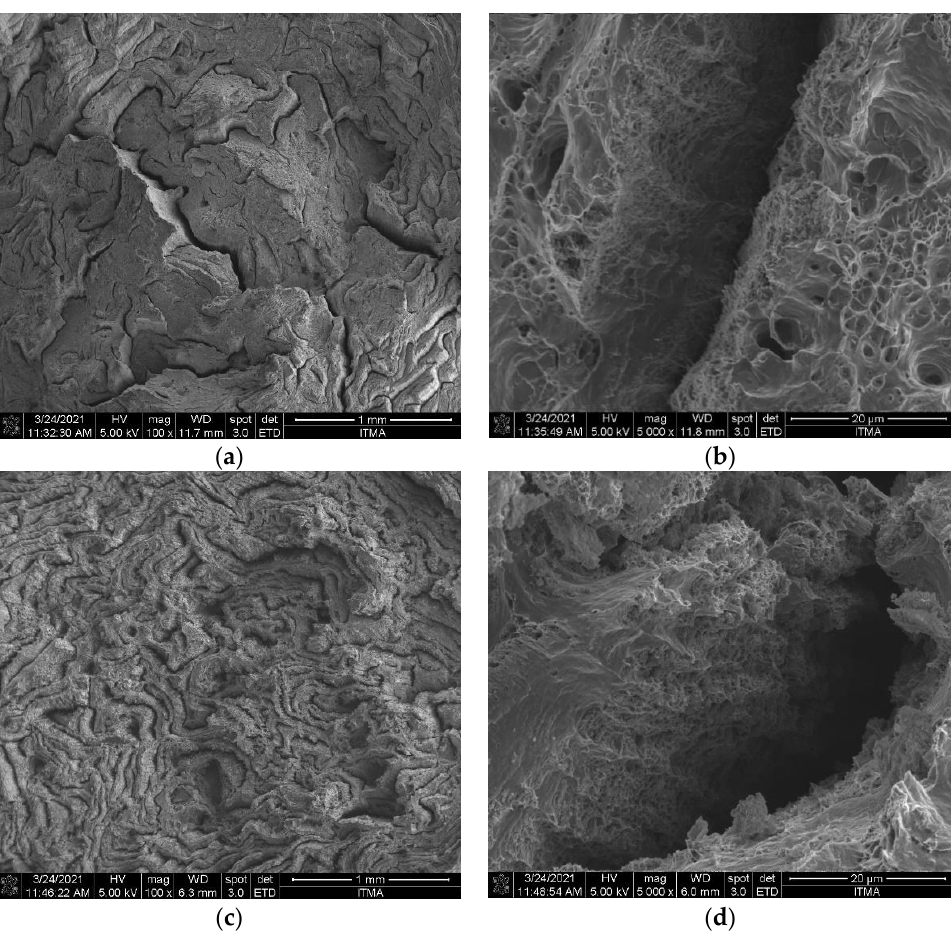
Figure 19. FESEM micrographs of fracture surface ( a ) AA6061 chips temp. 550 °C, time 3 h 100×, ( b ) AA6061 chips temp. 550 °C, time 3 h 5000×, ( c ) temp. 541 °C, time 2.25 h, CuO 2.13 vol%, SiO 2 1 vol% 100×, ( d ) temp. 541 °C, time 2.25 h, CuO 2.13 vol%, SiO 2 1 vol% 5000×.